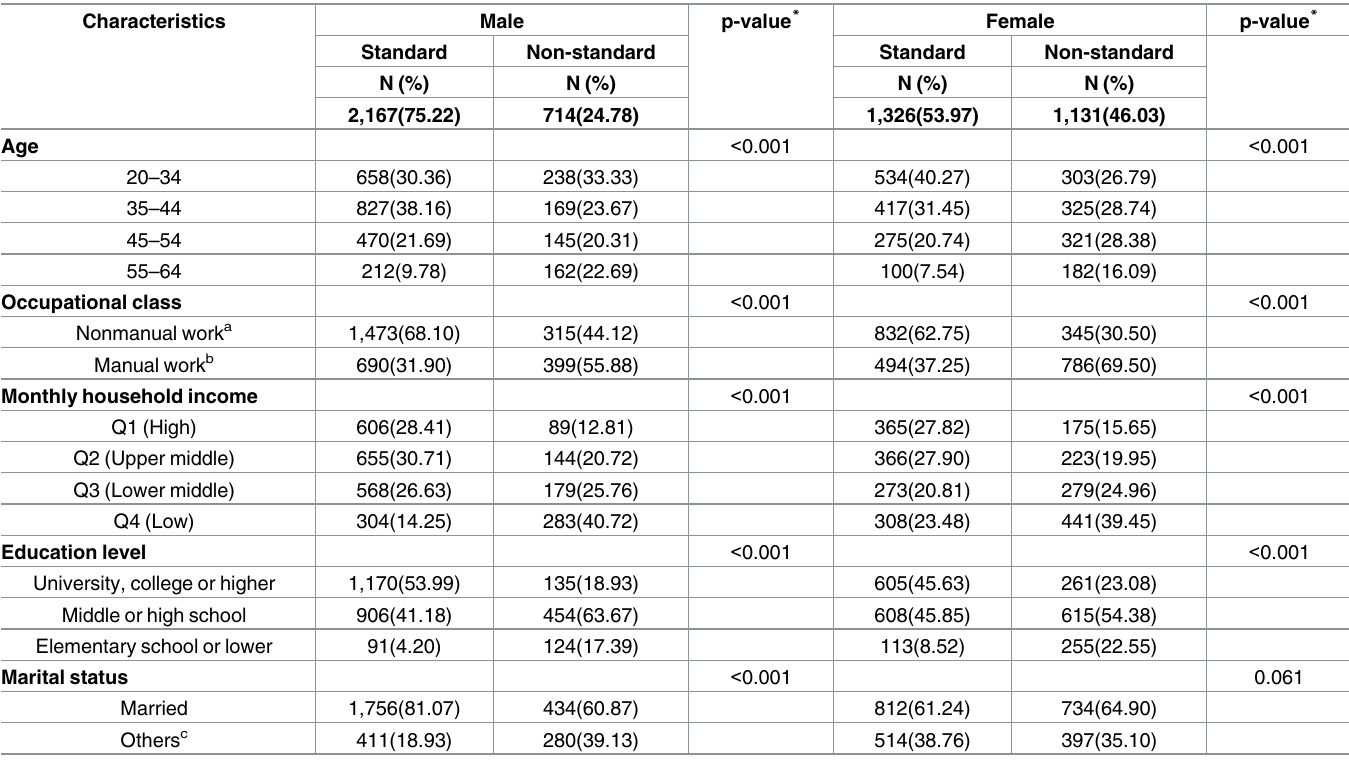
Table 1. Socio-demographic characteristics of the sample